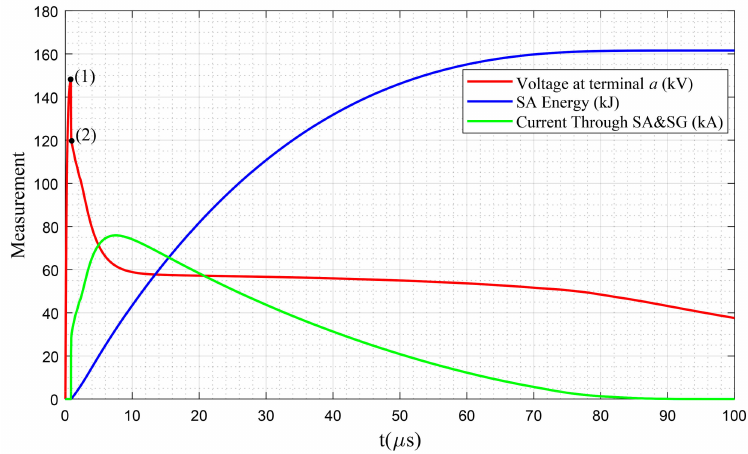
Figure 20. Performance of surge arrester and spark gap connected in series; scenario 3, SA-24b and SA-30b under 150 kV lightning